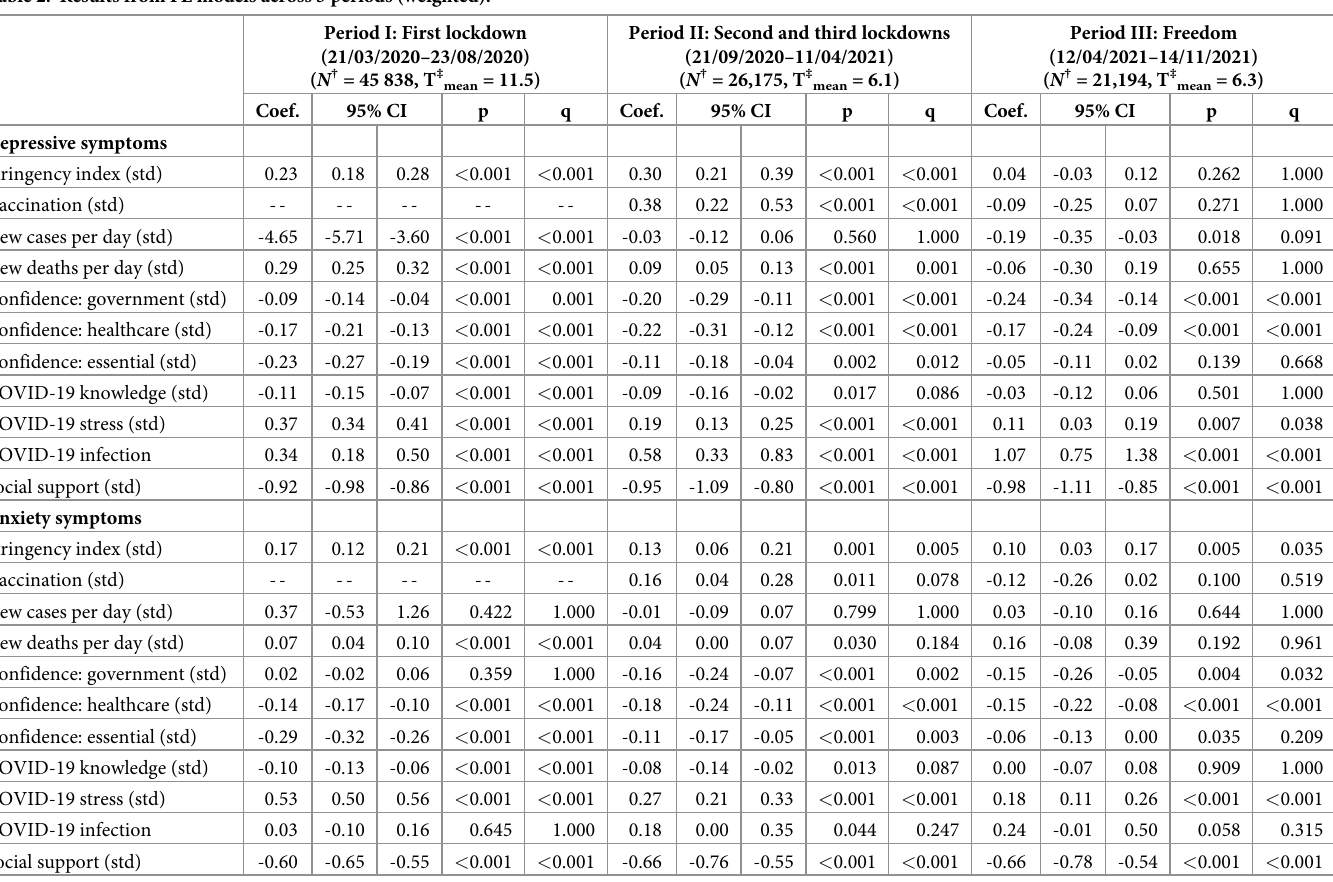
Table 2. Results from FE models across 3 periods